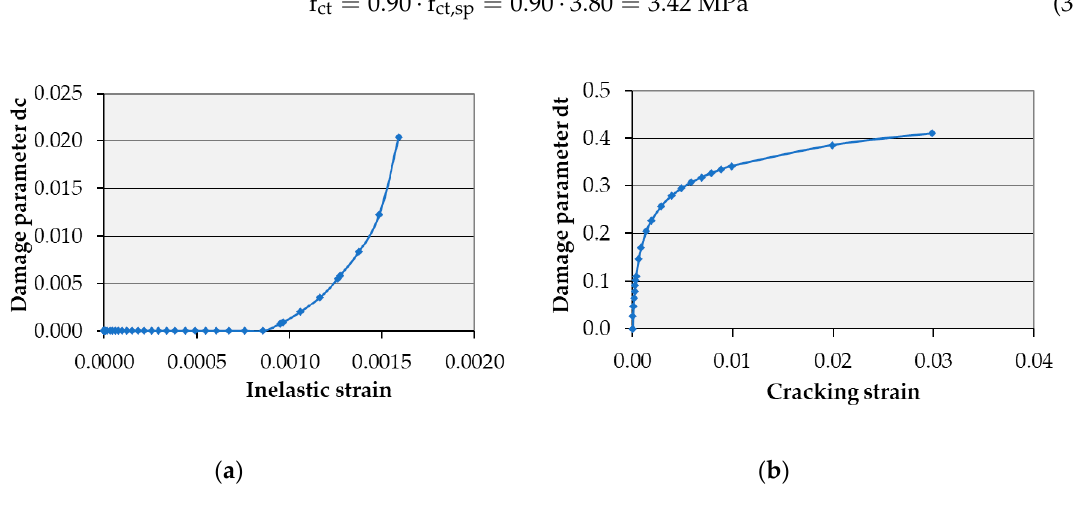
Figure 10. Concrete damage parameters depending on the inelastic strain: ( a ) compression d c ; ( b ) tension d t.